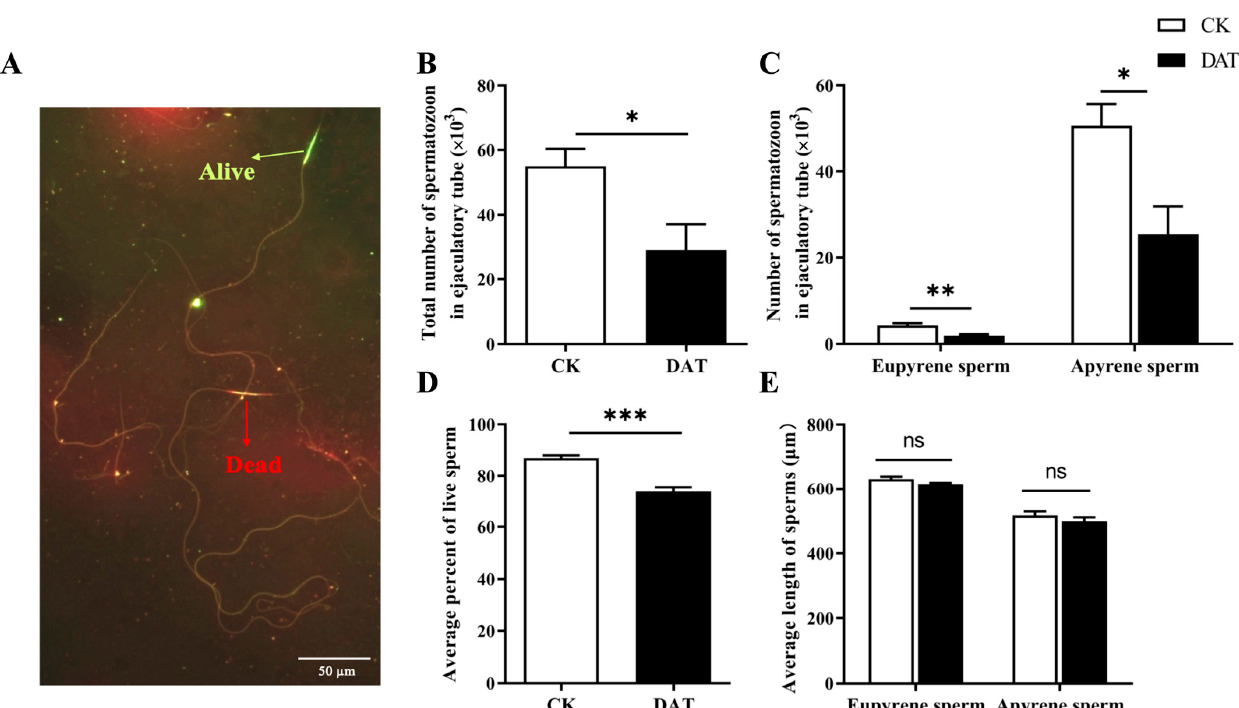
Figure 1. Quantification, survival and motility analysis of S. cerealella spermatozoa. ( A ) Representative images of viable sperm from adult seminal vesicles, stained with SYBR. Green marks live and red marks dead sperm. ( B – E ) Sperm-quantification assays. Three replicates and each replicate with 5 seminal vesicles were taken for each test (unpaired two-tailed t -test, *** p < 0.001, ** p < 0.01, * p < 0.05, ns = non-significant). Error bars depict standard error mean (SEM).